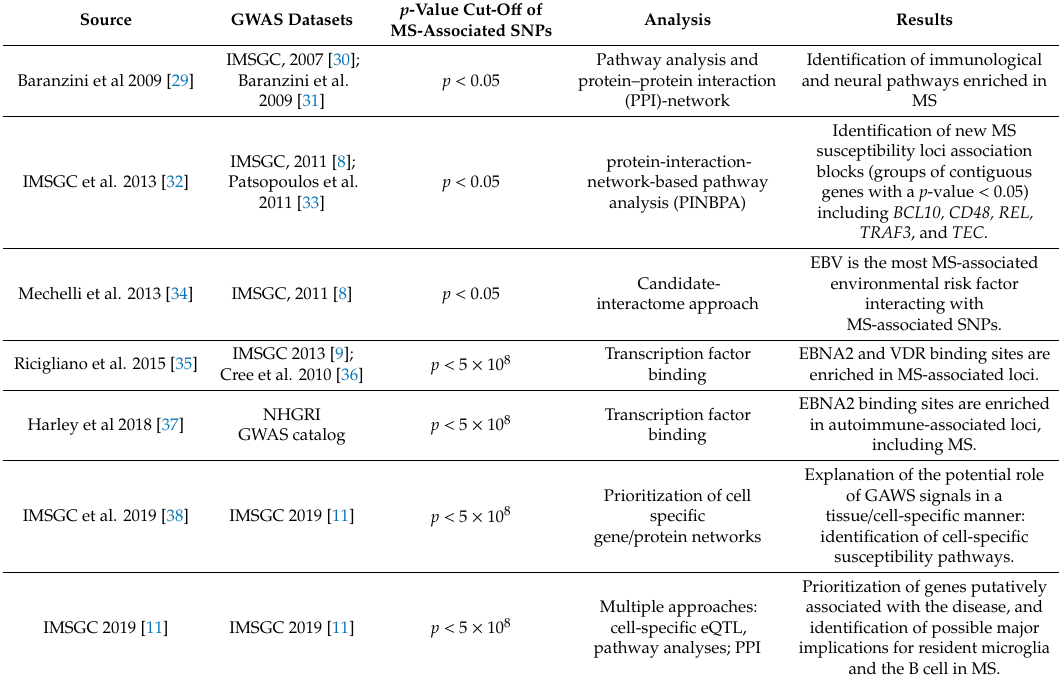
Source GWAS Datasets